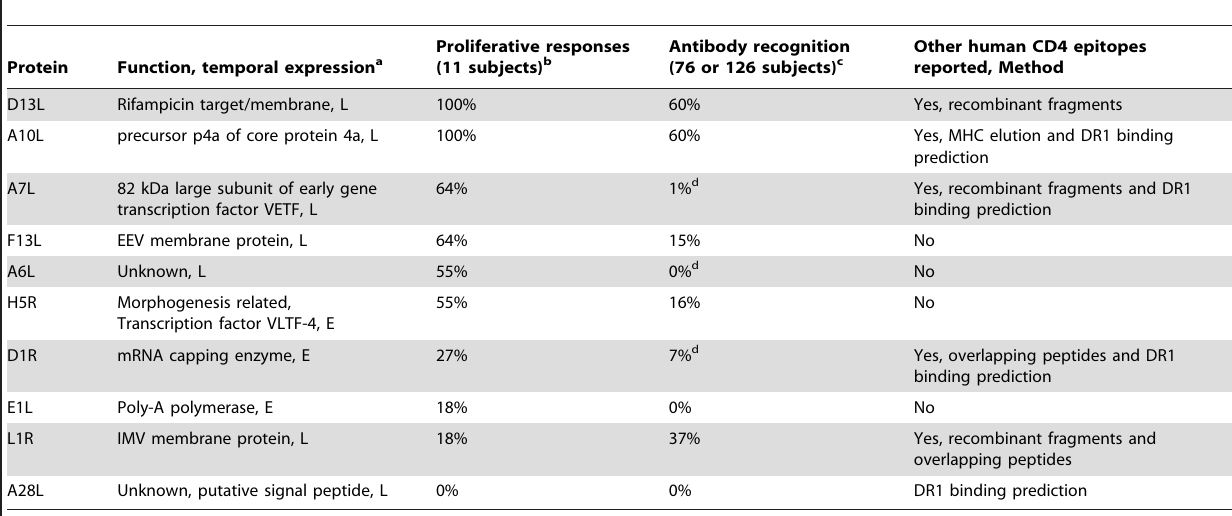
Table 2. Recognition of vaccinia proteins for which peptides have been identified using the ‘‘T cell driven’’ approach presented in this